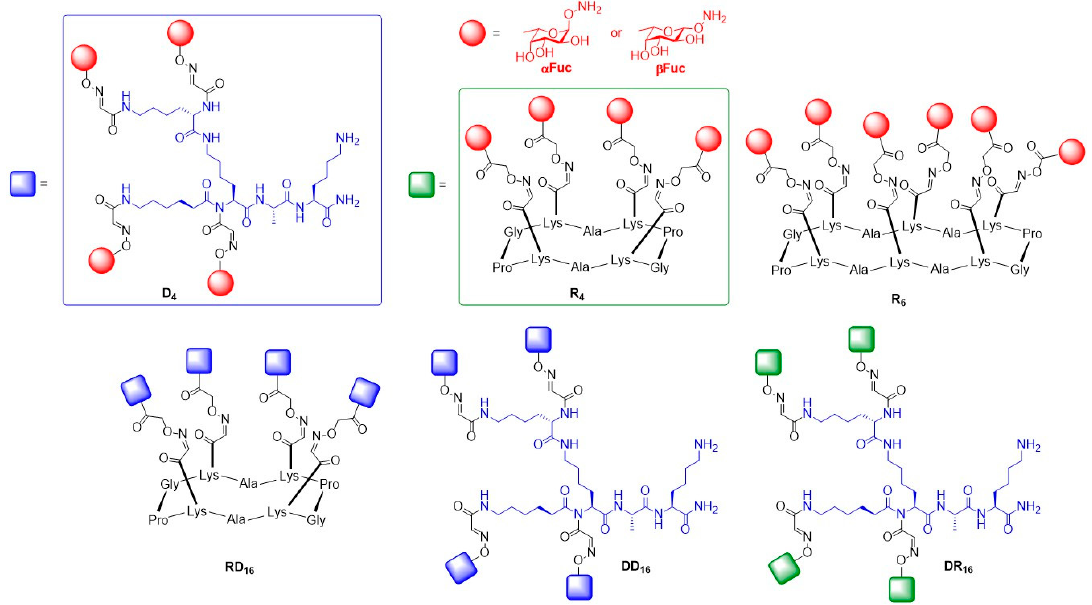
Figure 7. Structures of tetra- (R 4 and D 4 ), hexa- (R 6 ), and hexadecavalent (RD 16 , RR 16 , DR 16 , DD 16 ) fucosylated glycoclusters.